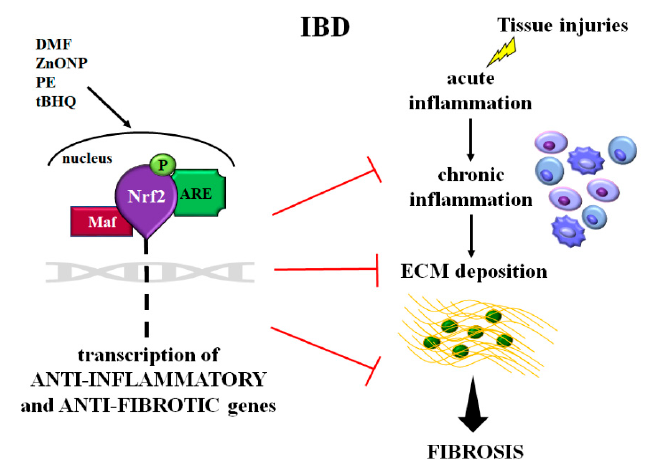
Figure 2. Schematic representation of the role of Nrf2 in intestinal inflammation and fibrosis occurring in inflammatory bowel disease (IBD). After tissue injuries, the cell’s response is characterized by a cascade of events: acute inflammation, chronic inflammation, and ECM proteins deposition leading to fibrosis. In these pathological events, Nrf2 is activated and then induces the transcription of the anti-inflammatory and antifibrotic genes. Molecules such as DMF, ZnONP, PE, and tBHQ, improving Nrf2 signaling, could be a new therapeutic strategy for intestinal inflammation and fibrosis. Abbreviations: ECM = extracellular matrix; Nrf2 = muclear factor-erythroid 2-related factor; Maf = musculoaponeurotic fibrosarcoma proteins; ARE = antioxidant responsive element; P = phosphorylated; DMF = dimethyl fumarate; ZnONP = ZnO nanoparticle; PE = Perilla frutescens ; tBHQ = tert -butylhydroquinone.